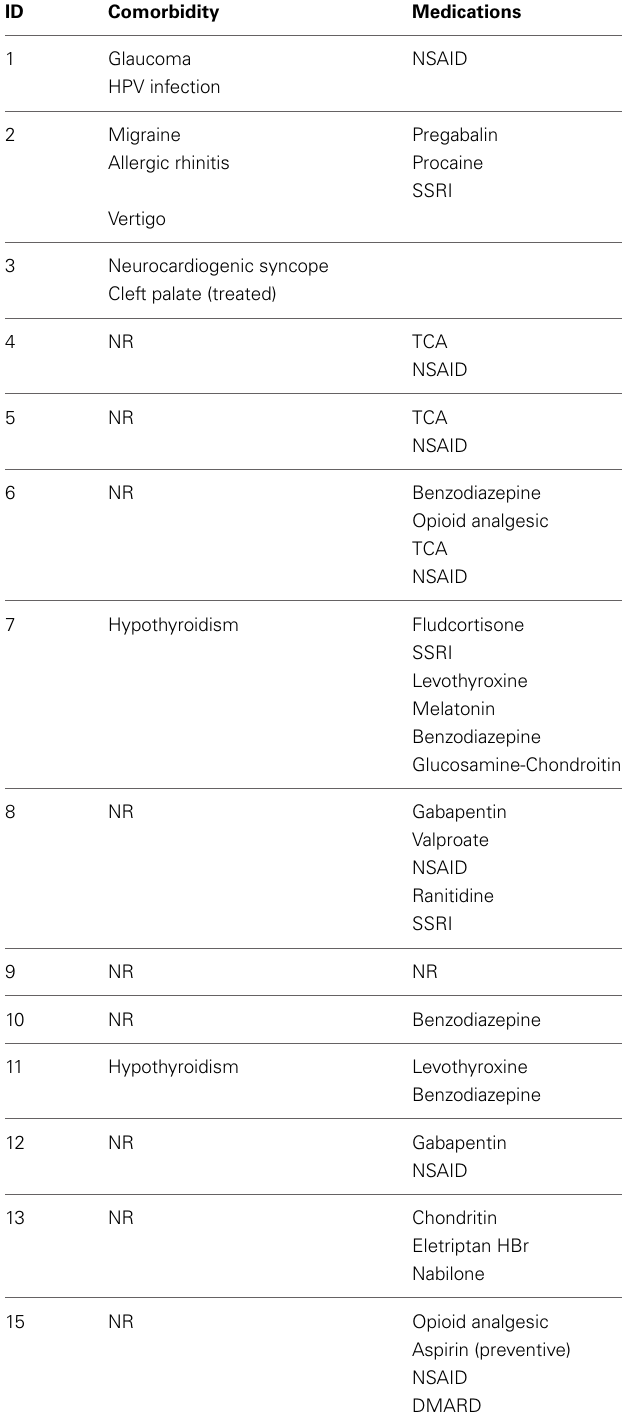
Table A1 | Medical history of the FM